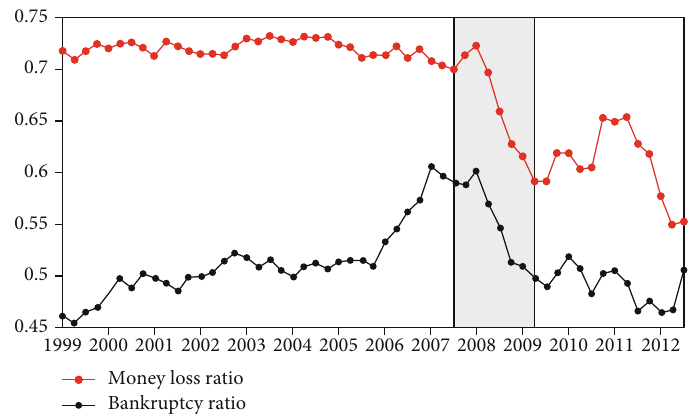
Figure 1: Relative liquidity loss compared to systemic risk given by the ratio of bankrupted banks